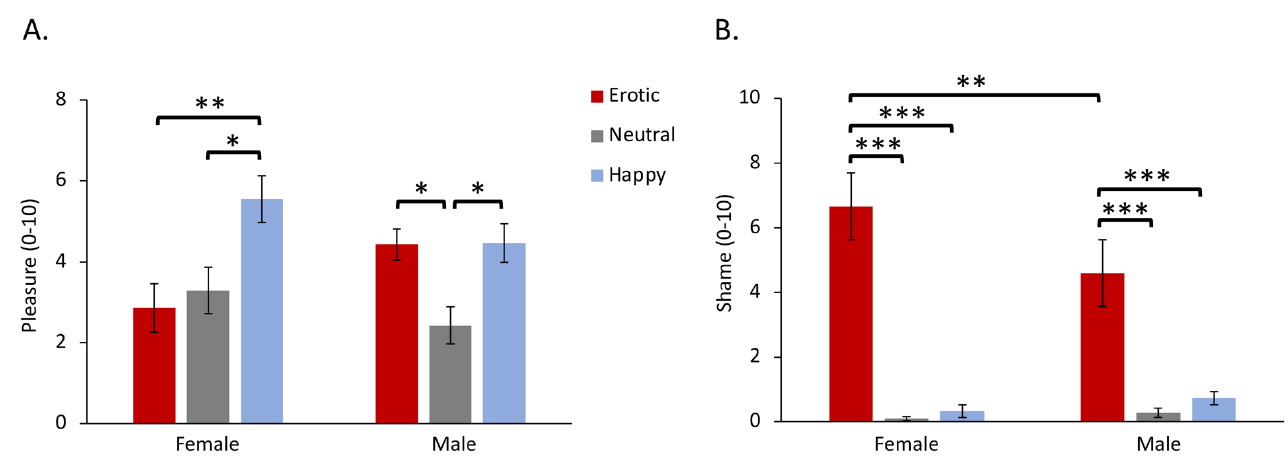
Figure 2. Self-reported pleasure ( A ) and shame ( B ) as a function of gender and stimuli. * p ≤ 0.05, ** p ≤ 0.01, *** p ≤ 0.001.